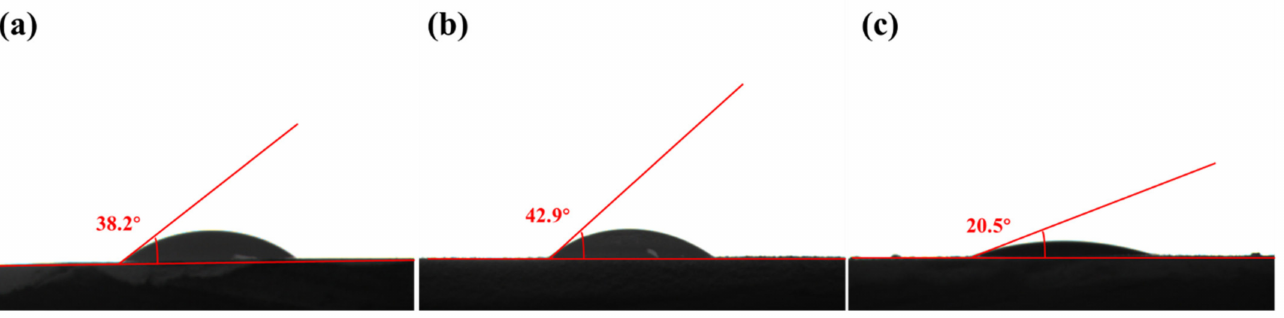
Figure 6. Water contact angle measurement result (( a ) TiO 2 –Al 2 O 3 membrane surface, ( b ) ZTA composite membrane surface without PEI addition, and ( c ) ZTA composite membrane